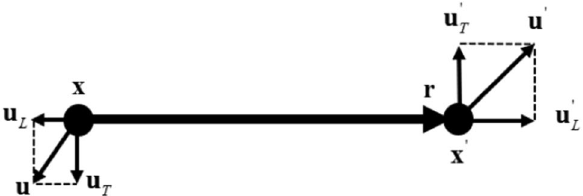
Figure 3. Sketch of longitudinal and transverse velocities, where u T and u ′ T are transverse velocities at two locations x and x ′ . u L and u ′ L are two longitudinal velocities.